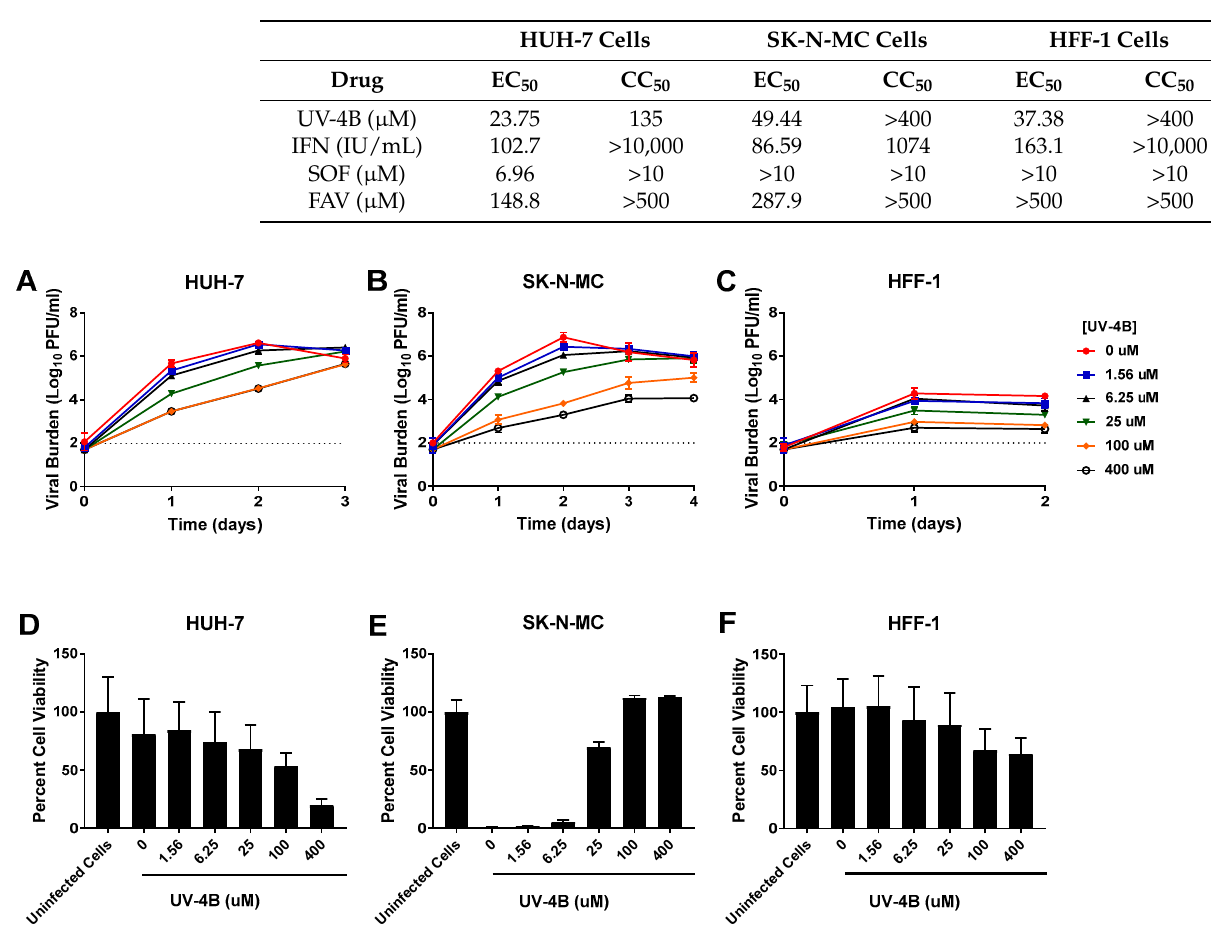
Figure 1. Antiviral activity of UV-4B against dengue virus (DENV) in HUH-7, SK-N-MC, and HFF-1 cells ( A – C ). HUH-7 ( A ) cells were infected at a multiplicity of infection (MOI) of 0.01, and SK-N-MC ( B ) and HFF-1 ( C ) cells were infected at an MOI of 0.1. Infected cells were treated with different concentrations of UV-4B. Viral burden was quantified via plaque assay on Vero cells, and reported as log10 plaque forming units per mL (PFU/mL). Data points represent the mean of three independent samples, and error bars correspond to one standard deviation. The dashed line signifies the assay limit of detection. ( D – F ) Effect of UV-4B treatment on cell viability of DENV-infected HUH-7 ( D ), SK-N-MC ( E ), and HFF-1 ( F ) cells. HUH-7, SK-N-MC, and HFF-1 cells were infected with DENV at MOIs of 0.01, 0.1, and 1, respectively, then treated with different concentrations of UV-4B. Cell viability was measured after three days with the commercially available WST-1 assay according to manufacturer specifications. Cell viability is reported as percent cell viability relative to an untreated, uninfected control. Columns represent the mean of 6 independent samples, error bars represent one standard